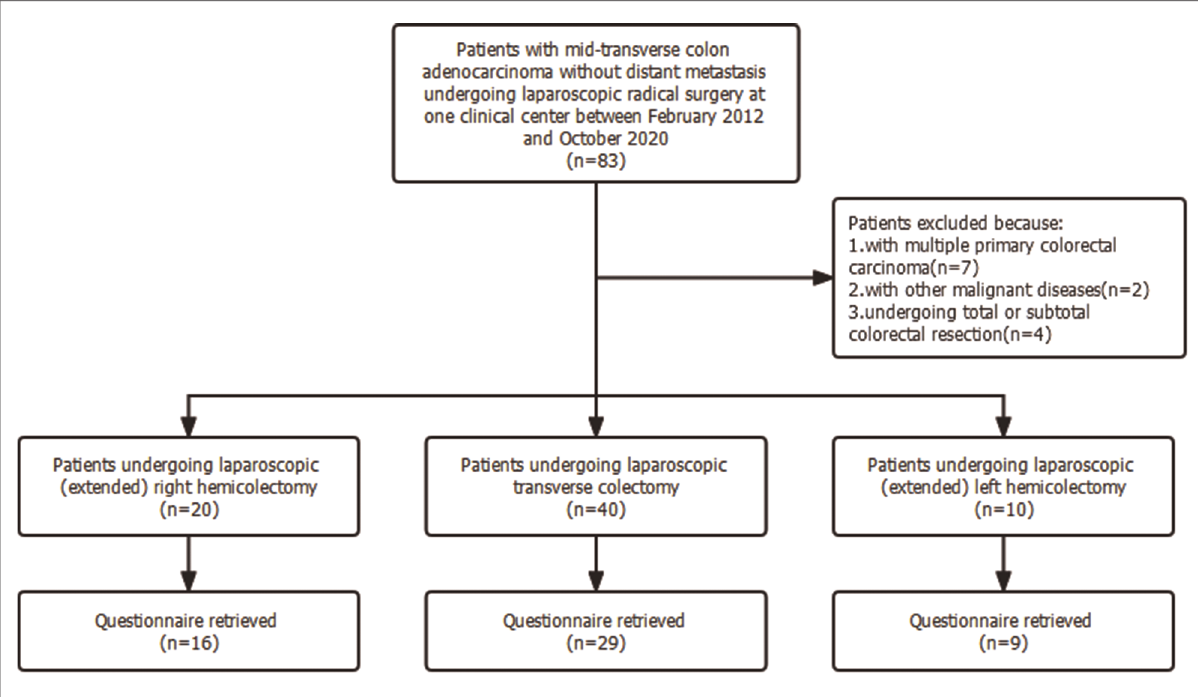
FIGURE 2 Flow diagram of the